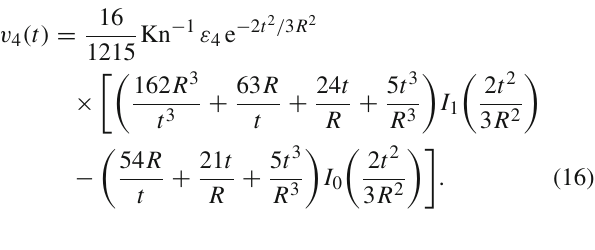
Fig. 7 Timedependenceofenergy-weightedtriangularflow v E tems with initially ε 3 = 0 . 15 and on average N resc . ≈ 0 . 02 (top left), 0.08 (top right) or 0 . 14 (bottom) rescatterings per particle. The green curves are for systems with elastic binary scatterings, the blue lines for